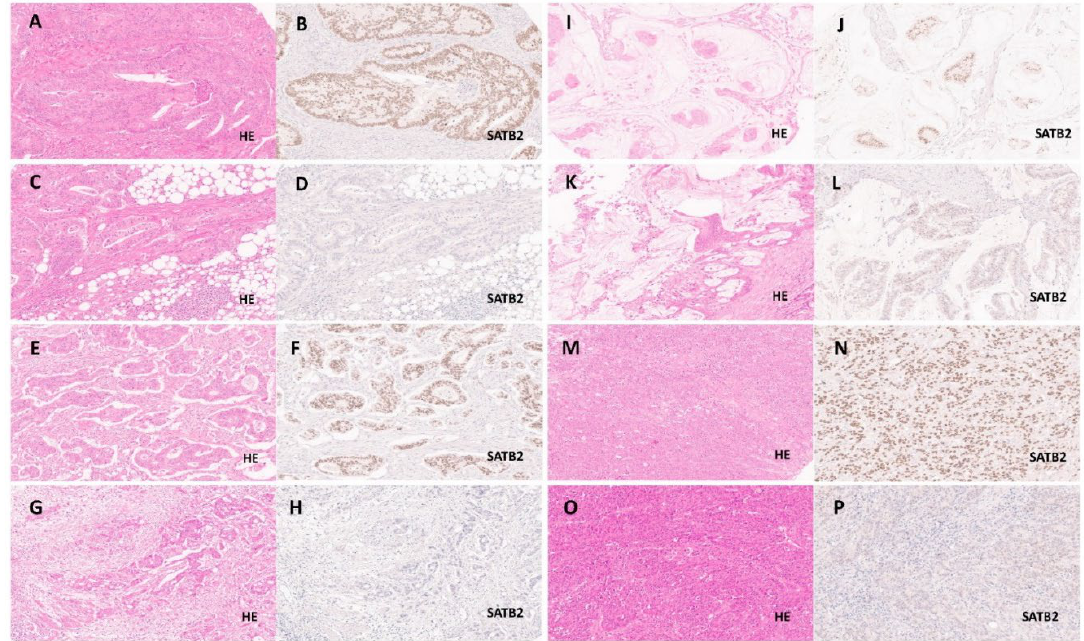
Figure 1. SATB2-low/absent and SATB2-high expression groups in selected colorectal carcinoma subtypes. ( A – D ): Adenocarcinoma NOS from the SATB2-high ((A): HE, 20× + (B): SATB2, 20×) and from association the SATB2-low/absent ((C): HE, 20× + (D): SATB2, 20×) expression subgroup. ( E – H ) : Micropapillary adenocarcinoma from the SATB2-high ((E): HE, 20× + (F): SATB2, 20×) and from association the SATB2-low/absent ((G: HE, 20× + (H: SATB2, 20×) expression subgroup, also shown as an example of carcinomas with a high tumour budding activity from both expression groups. ( I – L ): Mucin- ous adenocarcinoma from the SATB2-high ((I): HE, 20× + (J): SATB2, 20×) and from association the SATB2-low/absent ((K): HE, 20× + (L): SATB2, 20×) expression subgroup. ( M – P ): Medullary carcinoma from the SATB2-high ((M): HE, 20× + (N): SATB2, 20×) and from association the SATB2-low/absent ((O): HE, 20× + (P): SATB2, 20×) expression subgroup. 3.1.2. Association of SATB2-Groups with pTNM/UICC Staging, Morphologic Parameters (CRC Subtypes/Tumour Budding/WHO Grade) and Microsatellite Status As illustrated in Figure 2 and depicted in detail in Table S2, SATB2-low/absent CRCs were significantly enriched in higher pT/pN/pM and combined UICC-stages, right-sided tumours, carcinomas with lymphatic and blood vessel invasion as well as in tumours with positive margins ( p < 0.001, respectively). Compared to SATB2-high neoplasms, SATB2- low/absent CRCs were significantly increased in CRCs with high (Bd3) tumour budding activity and in poorly differentiated carcinomas according to the WHO grade ( p < 0.001, respectively). Furthermore, a low/absent SATB2 expression was significantly enriched in the mucinous, micropapillary, medullary and signet-ring CRC subtypes as well as in MANEC/NEC ( p < 0.001). MSI-H CRCs were also associated with an absent or low SATB2 expression ( p = 0.01). 3.1.3. Association of SATB2 Expression Groups with CDX2 Expression Groups Far more CRCs were allocated to the SATB2 low/absent expression group than to the CDX2 low/absent expression group (CDX2: 10.2% vs. SATB2: 22.2%). Although both ex- pression groups were associated with one another ( p < 0.001), there were many tumours with a discordant SATB2/CDX2 expression status (Kappa Cohens value: 0.30). For exam- ple, only 28% (64/231) of CRCs from the SATB2-low/absent subgroup showed a concord- ant low/absent CDX2 expression, while 40% (42/106) of CDX2-low/absent CRCs showed a high SATB2 expression level. Sixty CRCs (6%) showed a complete absence of SATB2 expression compared to only 13 CRCs (1.3%) that showed a complete negativity for CDX2. Only two CRCs remained negative for both markers, while the rest of the CRCs without any SATB2 expression showed a heterogeneous ( n = 19, 32%) or diffuse expression of